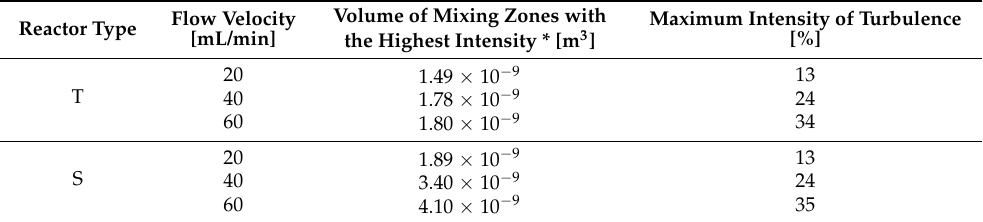
Table 2. The volume of mixing zones with the highest intensity and maximum intensity of turbulence for T- and S-type